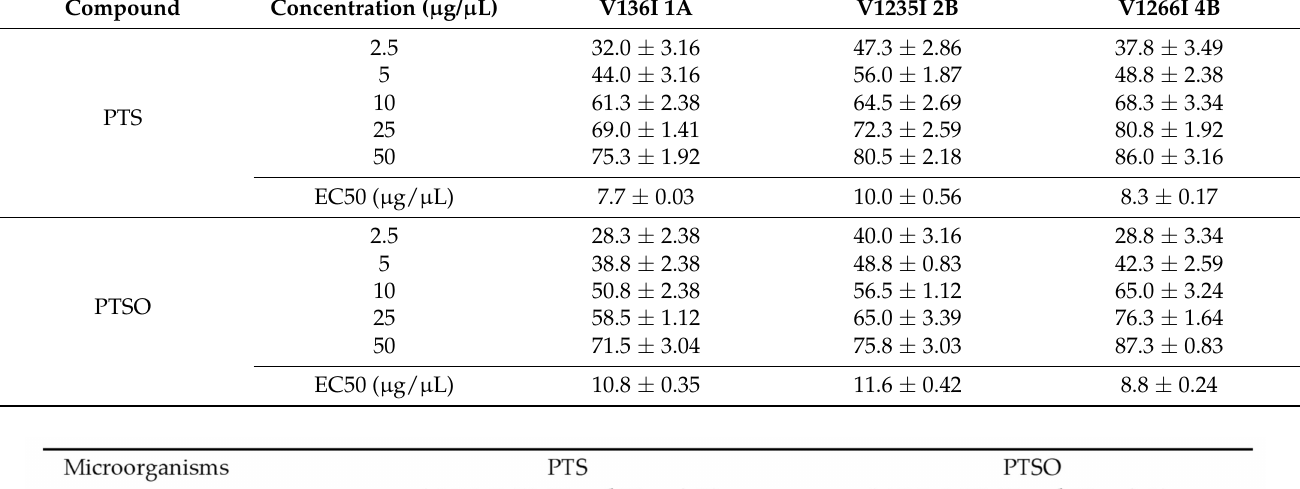
Table 2. Antifungal activity of PTS and PTSO against different Verticillium dahliae isolates (V136I 1A, V1235I 2B and V1266I 4B) using the disk-diffusion method, expressed as the average diameter ± standard deviation of inhibition zone (mm), and EC50 values.